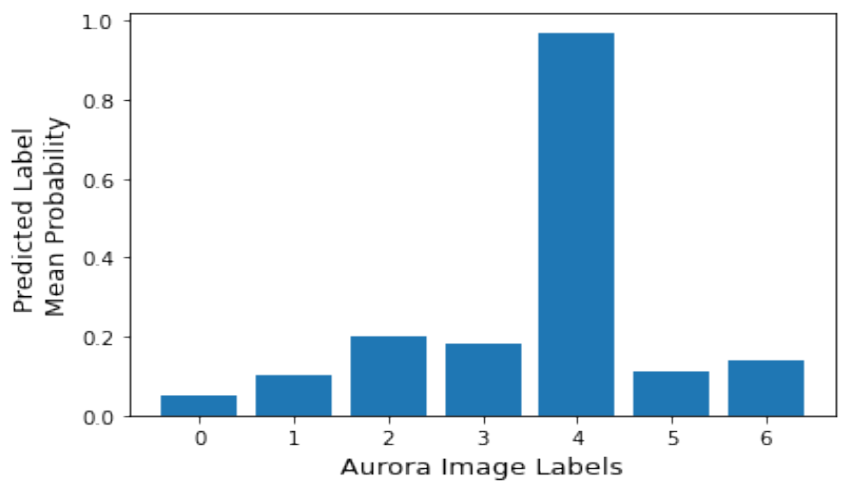
Figure 4. An instance of predicted label mean probability with test observation belonging to label-4. Each bar corresponds to the mean probability of a test input image belonging to a particular label.